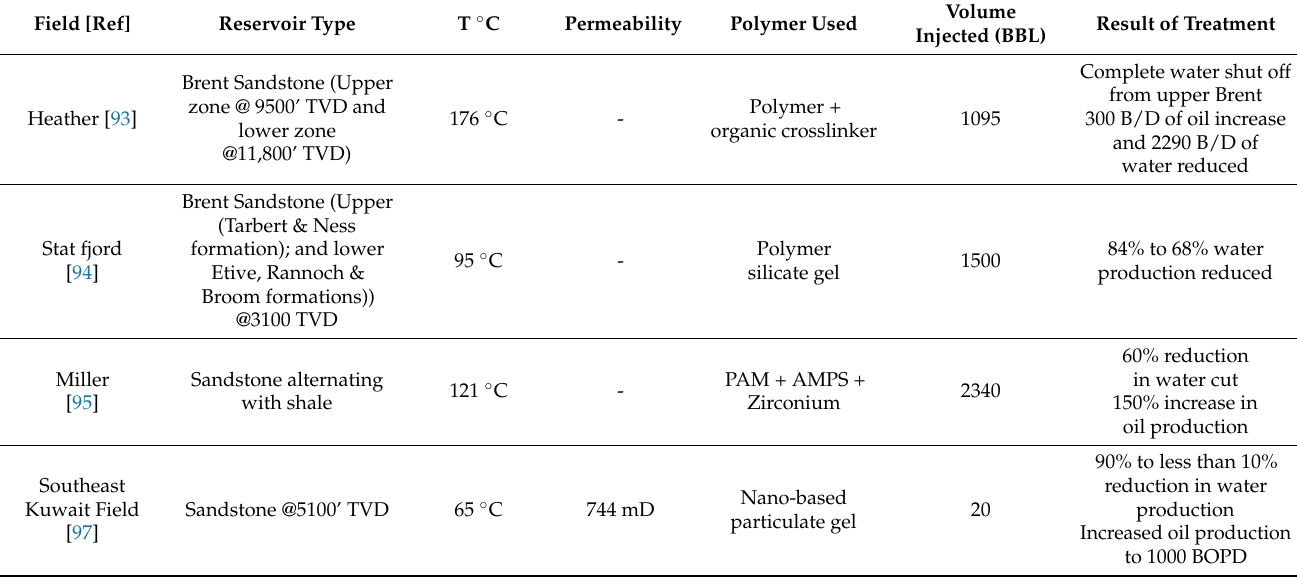
Table 1. Summary of field properties for the case